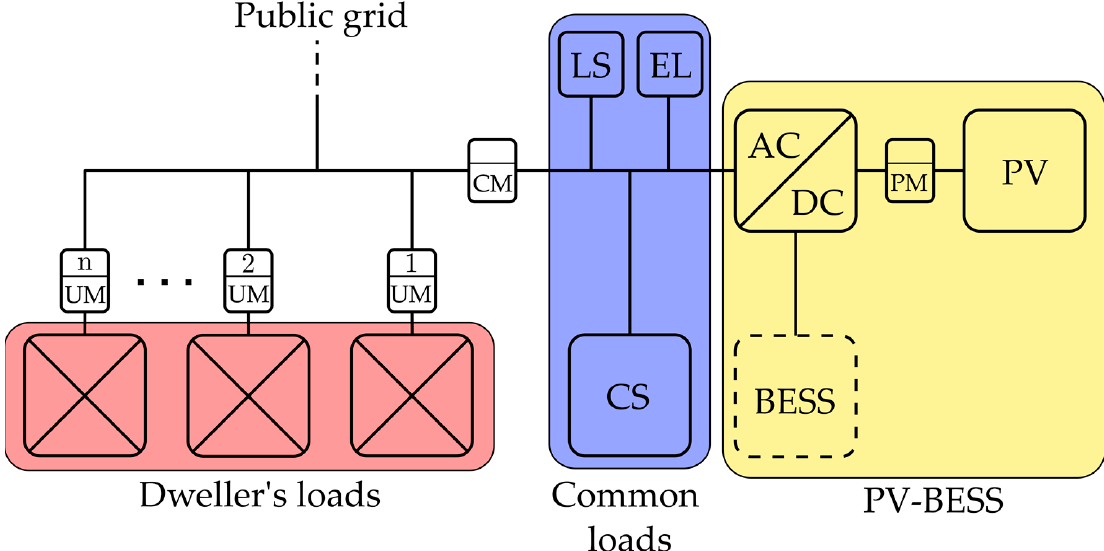
Figure 1. Considered JARSC system electrical schematic composed by dweller’s load, PV-BESS system, and common loads consisting of lighting system (LS), elevator (EL), and the electric vehicle charging station